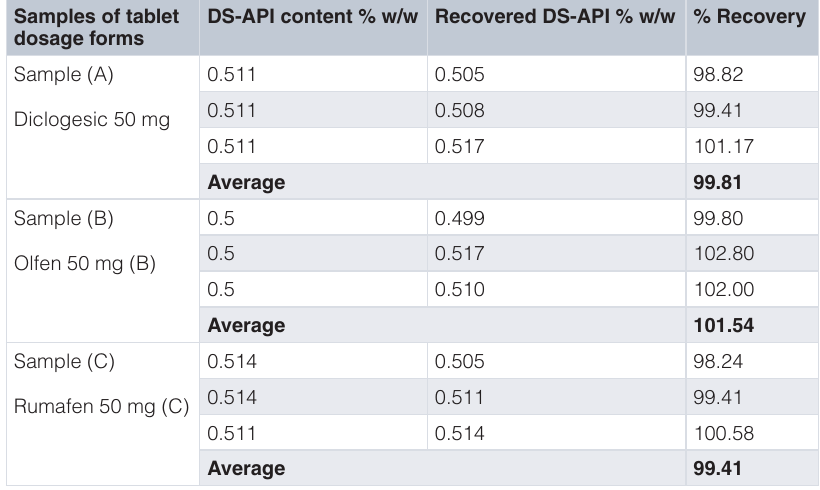
Table 2. FTIR quantitative analysis of different DS tablet dosage